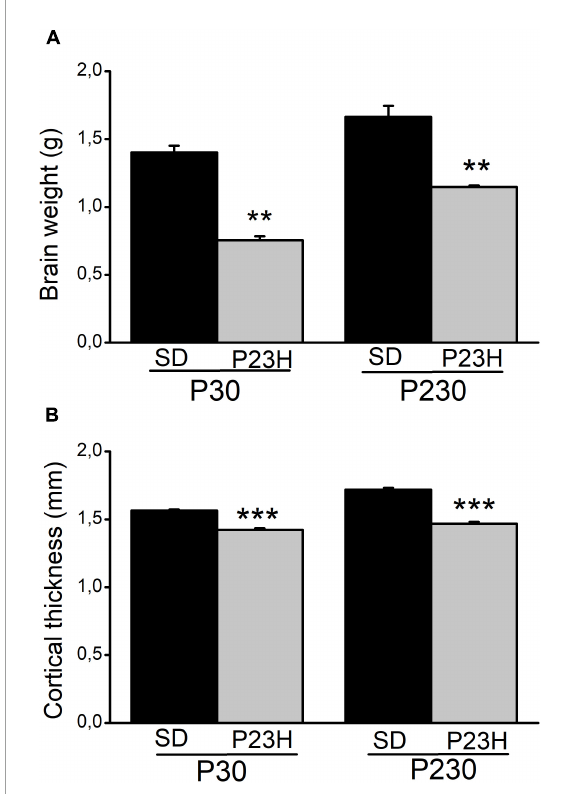
FIGURE1 Brain weight and visual cortical thickness of the SD and P23H rats at P30 and P230. (A) Brain weight and (B) cortical thickness increased with age in both conditions but they were smaller in P23H compared to the SD rats. Differences were statistically significant with ** p < 0.01 according to the Student’s t -test (A) and with *** p < 0.001 according to the Mann-Whitney U -test (B)